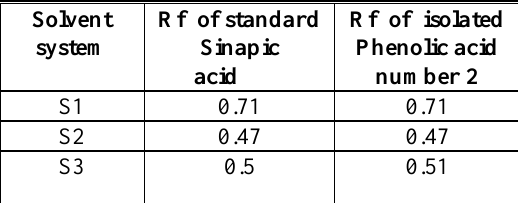
Table 4. TLC profile of isolatedi compound number 2 compared with sinapic acide standard using the mobile phase solvents ( S1, S2, S3)